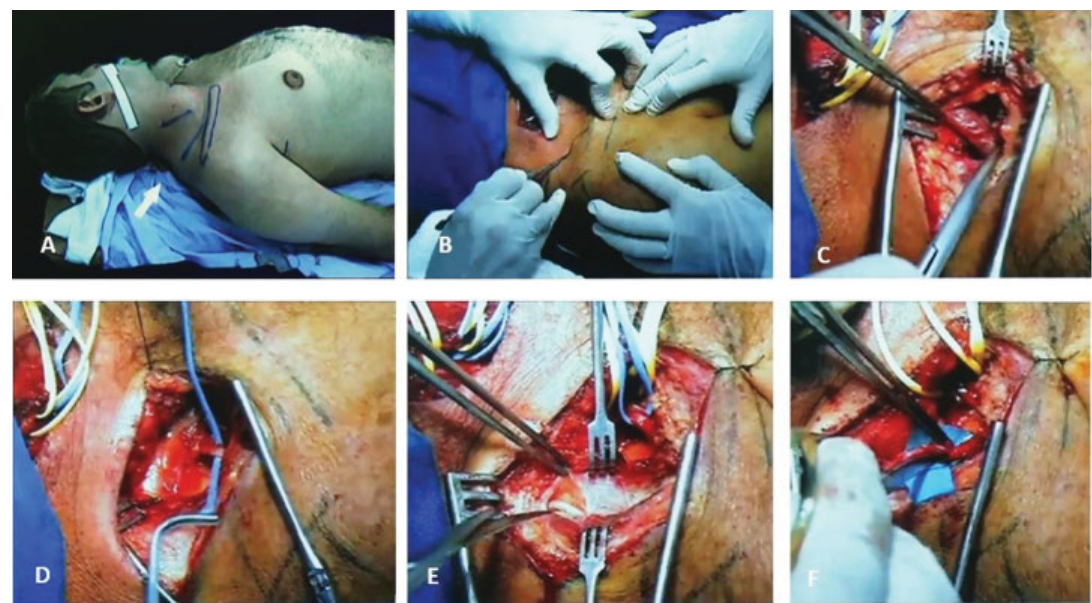
Fig. 3 Nerve transfer of accessory nerve to the suprascapular nerve. 20 ( A ) Patient positioning and skin incision. ( B ) Beginning of the surgery. ( C ) Dissection of omohyoid muscle. ( D ) Dissection of suprascapular nerve. ( E ) Dissection of accessory nerve on anterior margin of trapezius muscle. ( F ) Nerve stumps prepared for nerve